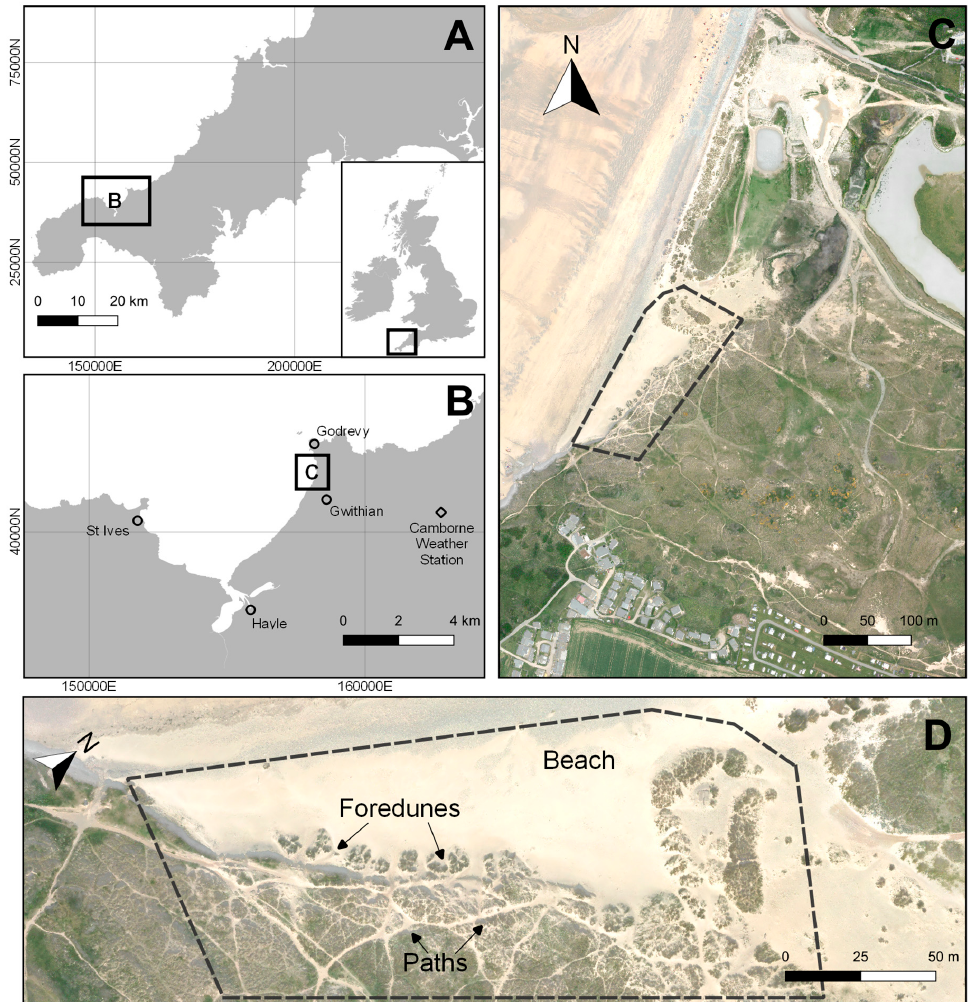
Figure 1. ( A ) The location of St Ives bay and Gwithian Towans within the UK and Cornwall; ( B ) The location of St Gothian Sands Local Nature Reserve; ( C ) An aerial image (courtesy of Channel Coastal Observatory, https://www.channelcoast.org/) with the dune study system (area of interest) indicated by dashed line; ( D ) The study system annotated with features of